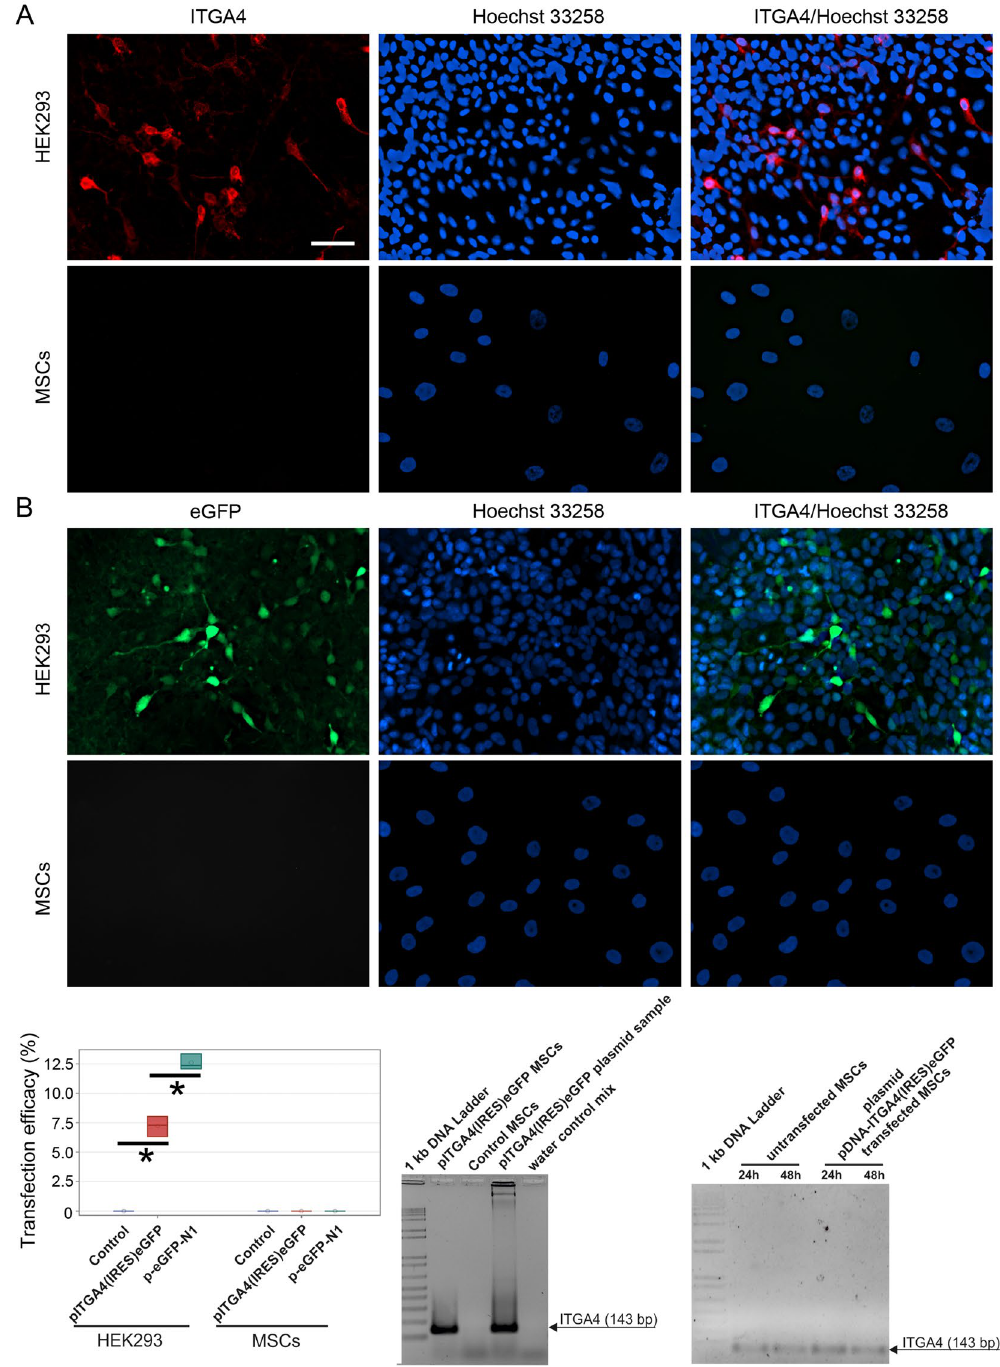
Figure 1. Plasmid DNA-based transfections of MSCs and HEK293 cells. MSCs and HEK293 visualized 24 h post transfection by immunofluorescence after pITGA4(IRES)eGFP plasmid ( A ) and p-eGFP-N1 plasmid ( B ). Quantification of percentage of cells expressing transgenes [pITGA4(IRES)eGFP/red/, p-eGFP-N1/green/] ( C ). PCR for presence of pITGA4(IRES)eGFP plasmid in MSCs 24 h after transfection ( D ). PCR for presence of itga4 mRNA in MSCs transfected with pITGA4(IRES)eGFP ( E ). The arrows point on PCR-product corresponding itga4 gene (143 bp). Error bars are box-and-whiskers plots containing the mean, quartiles (box) and minimum and maximum observations (whiskers). Transfection efficiencies have been calculated from three independent experiments. Scale bar located in the top left image: 20 µ